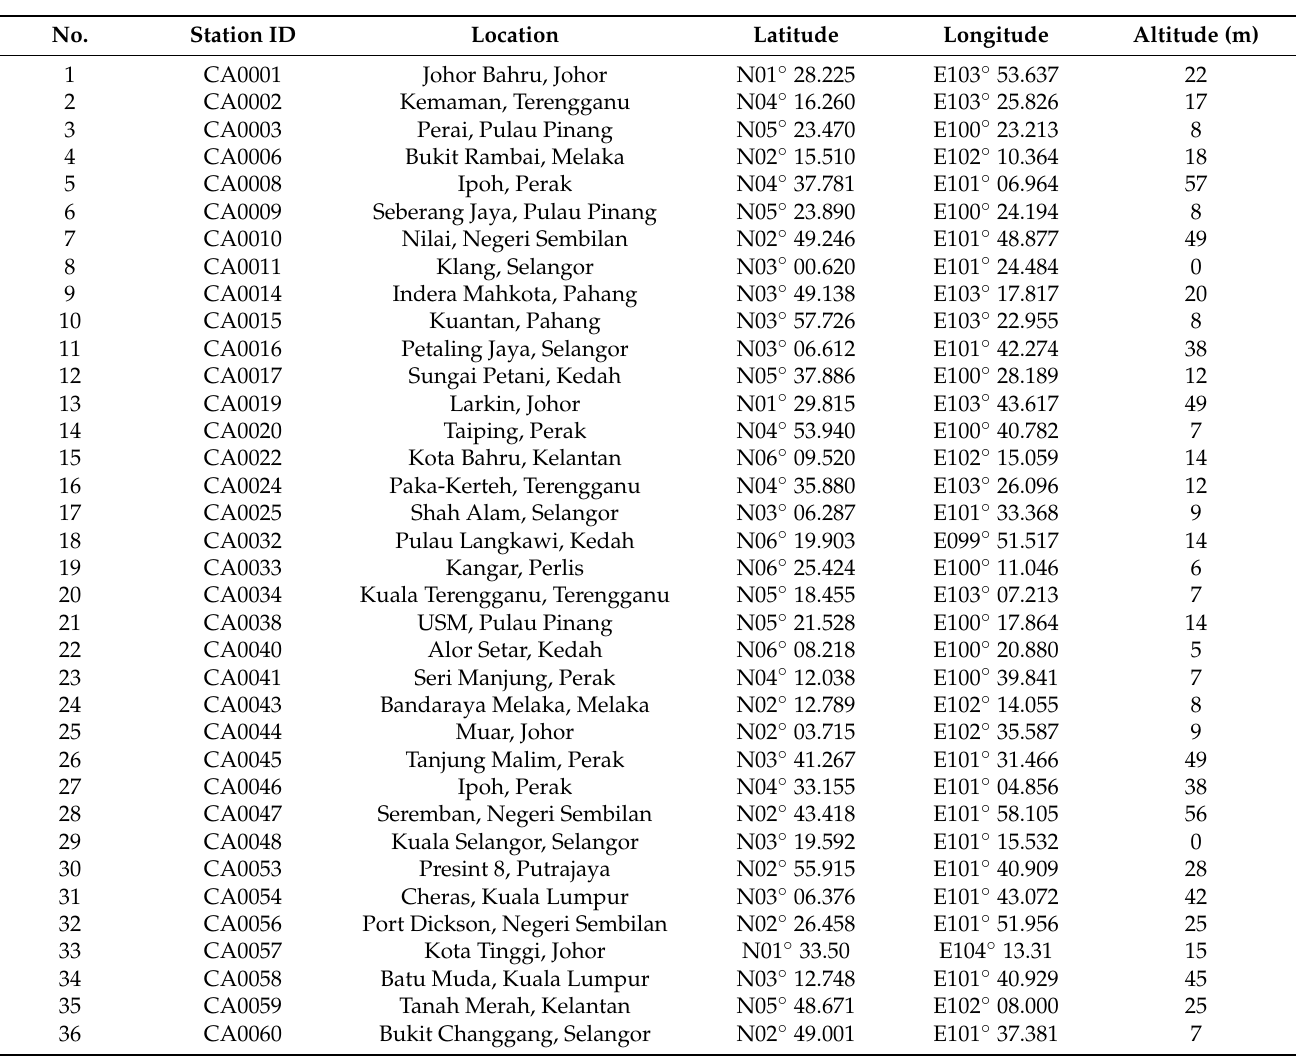
Table 1. The AWS location and